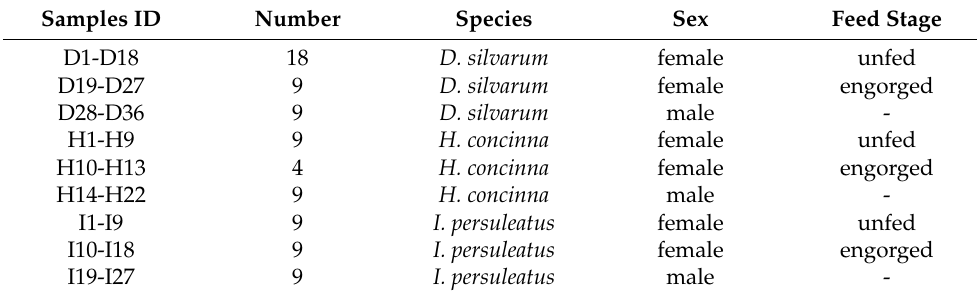
Table 1. The information of the ticks collected in this